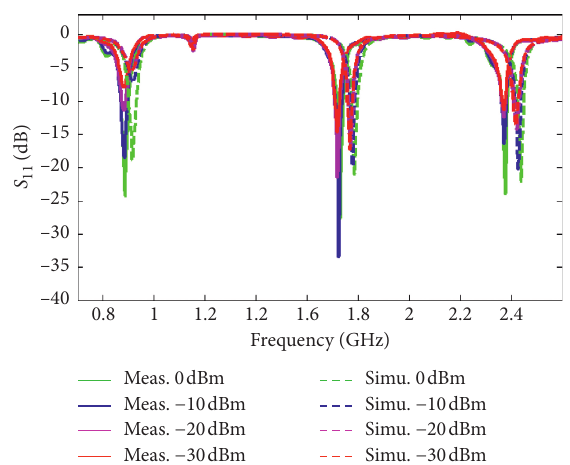
Figure 24: Simulated and measured S 10k Ω